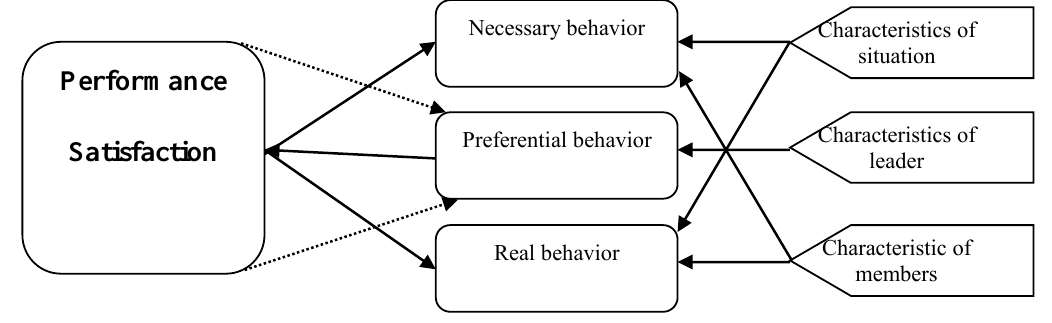
Figure 1. Multi-dimensional model of leadership in sports